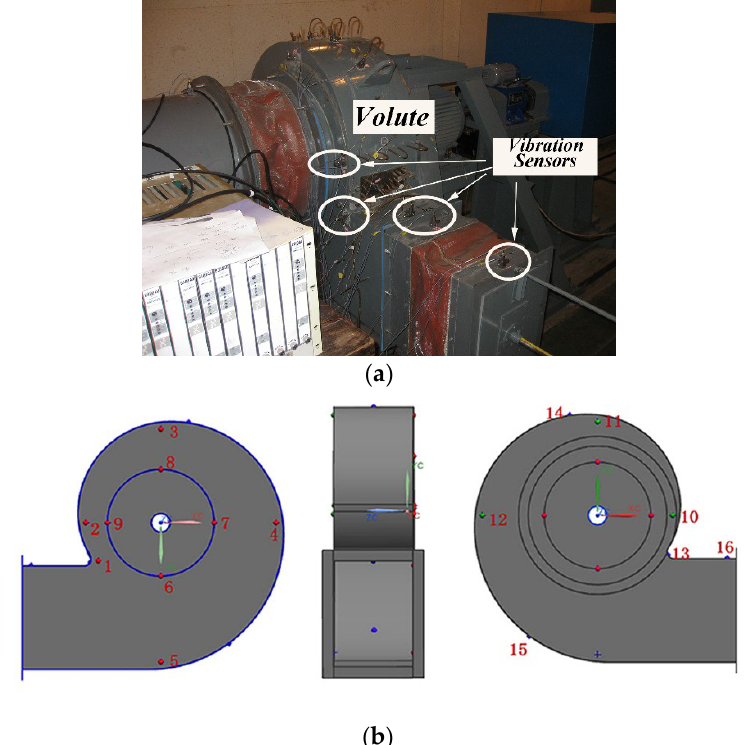
Figure 10. The arrangement of the vibration sensor. ( a ) The distribution of measuring points of experiments; ( b ) The distribution of measuring points of simulation.